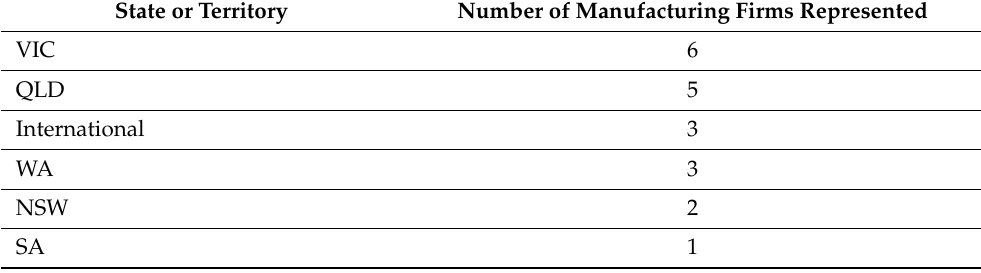
Table 3. Representation across Australian States and Territories. State or